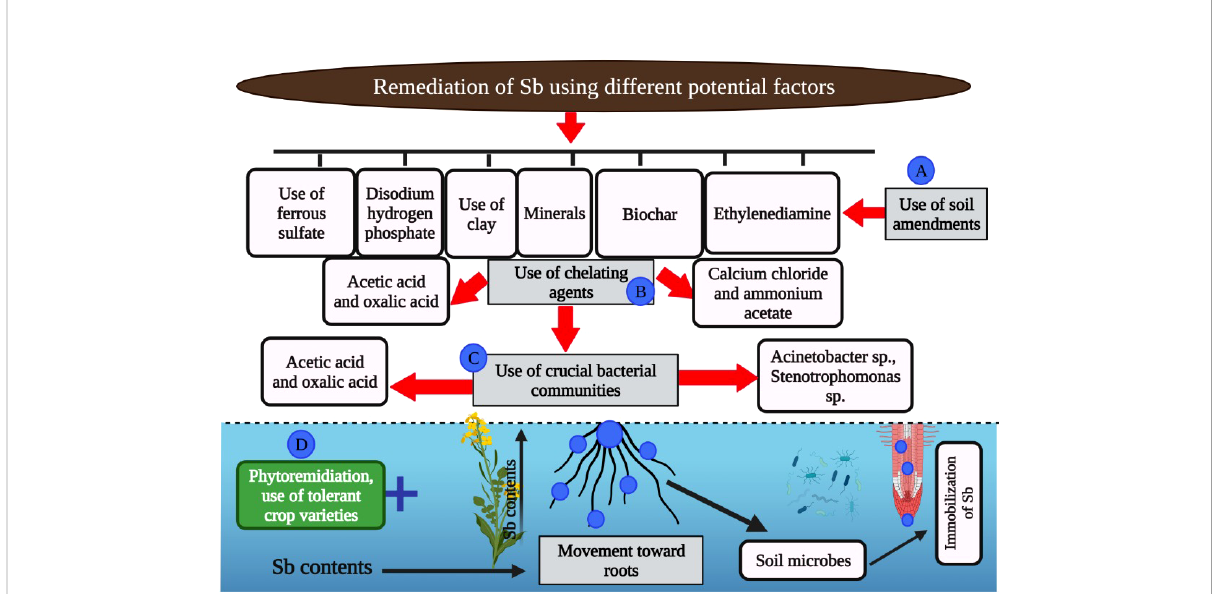
FIGURE 3 The role of various amendments to mitigate the Sb toxicity in plants. The various carbon based amendments (biochar), chemical treatments (ferrous sulphate, acetic acid, oxalic acid, ammonium acetate, and ethylenediamine) and microbes can cause immobilization of Sb which in turn reduce the toxic effects of Sb on